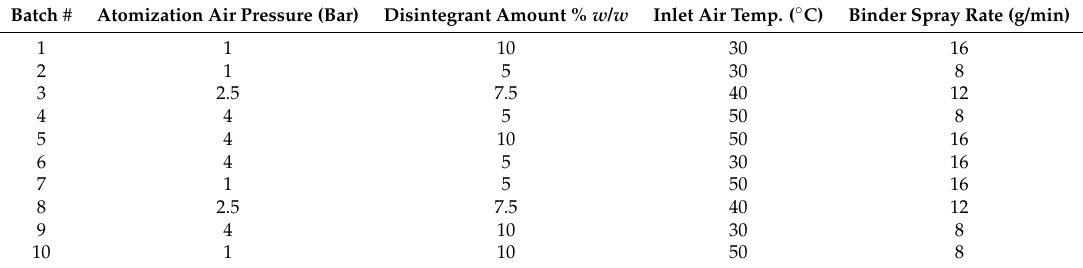
Table 3. Various design of experiemnts (DOE) settings for fluid bed granulation (FBG)